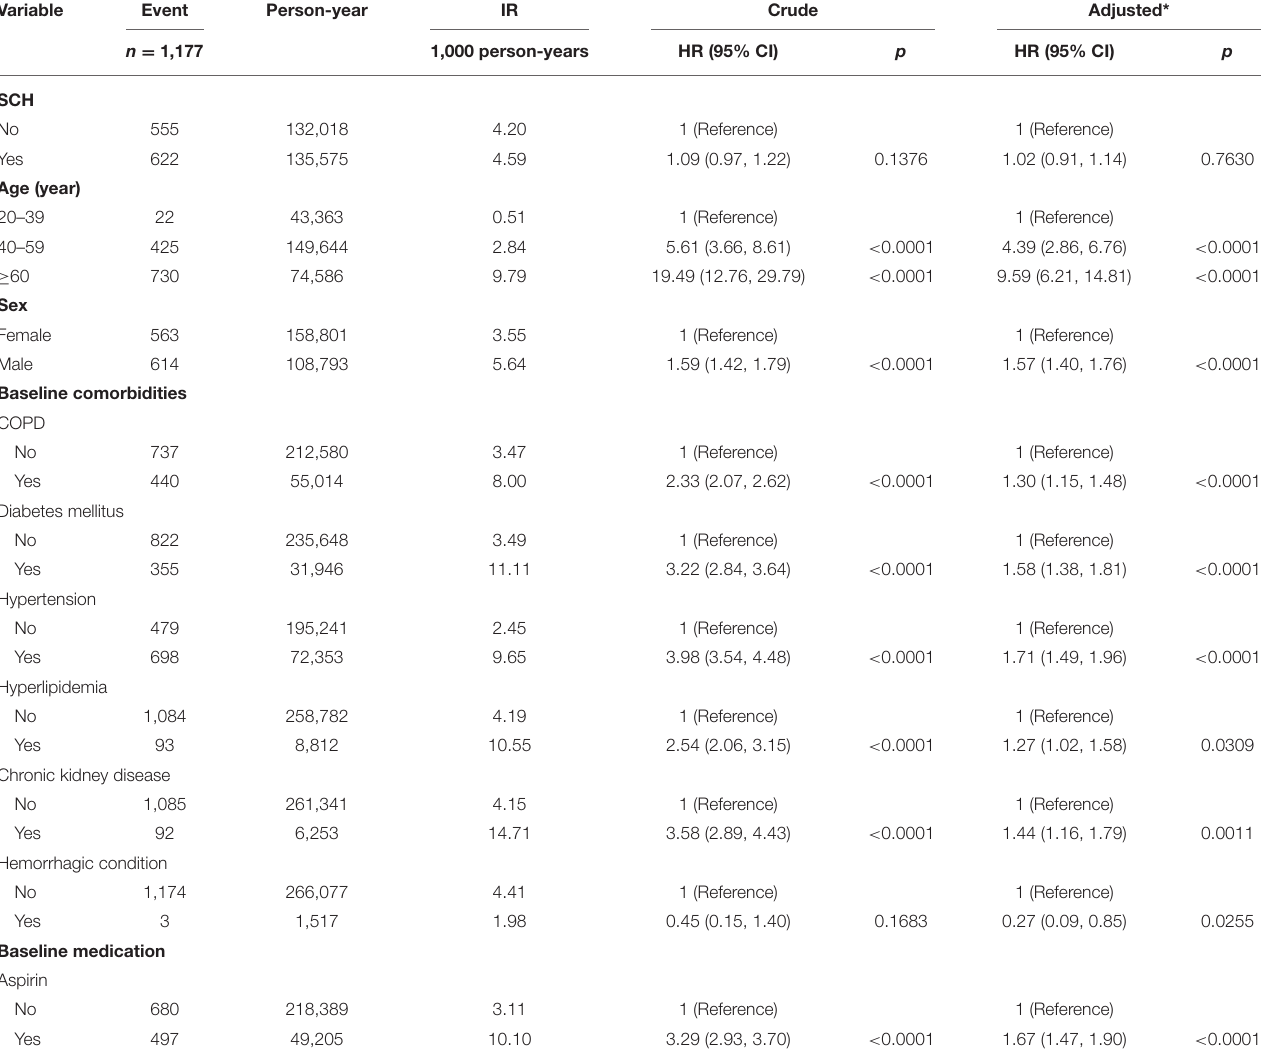
TABLE 2 | Cox regression analyses of risk factors associated with acute coronary syndrome among patients.